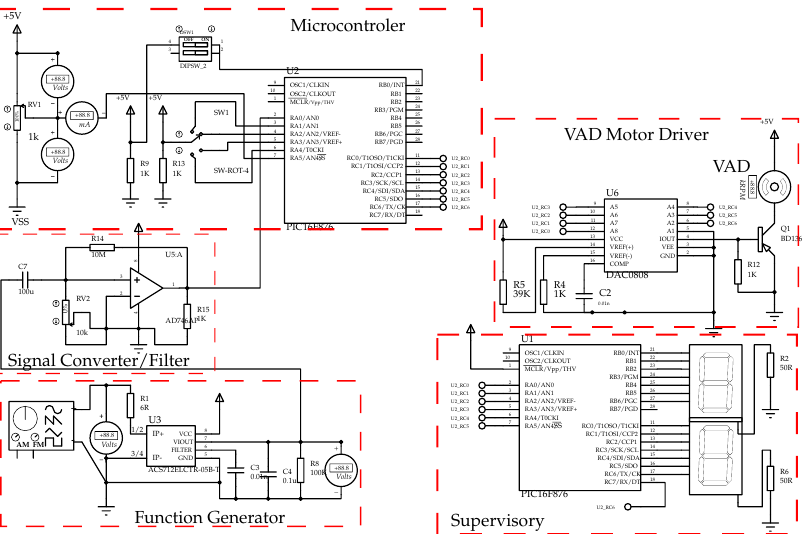
Figure 9. Electronic circuitry developed for the design of the supervisory control. The VAD mo- tor driver controls the blood flow. The VAD control is running at the microcontroller. The func- tion generator creates failures in the system, for example increase the heart beating. The signal converter/filter interfaces the signal to the microcontroller. The supervisory is responsible of the human-machine